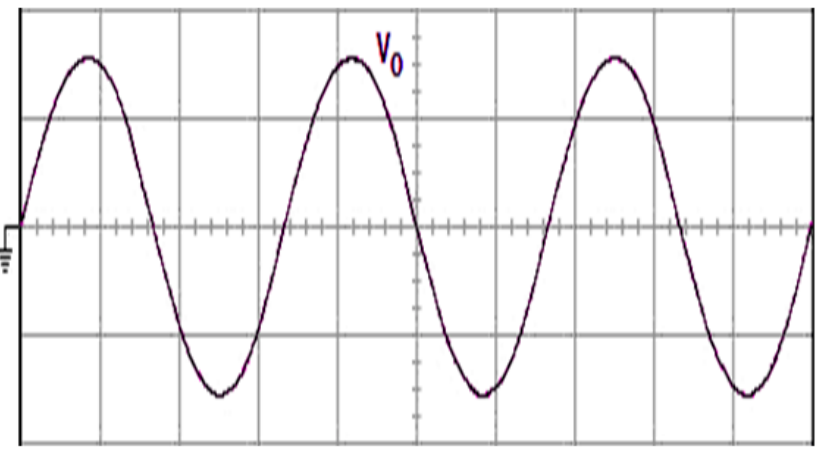
Figure 11. Experimental waveform under a LC variation for the modified control technology (100 V/div; 5 ms/div).